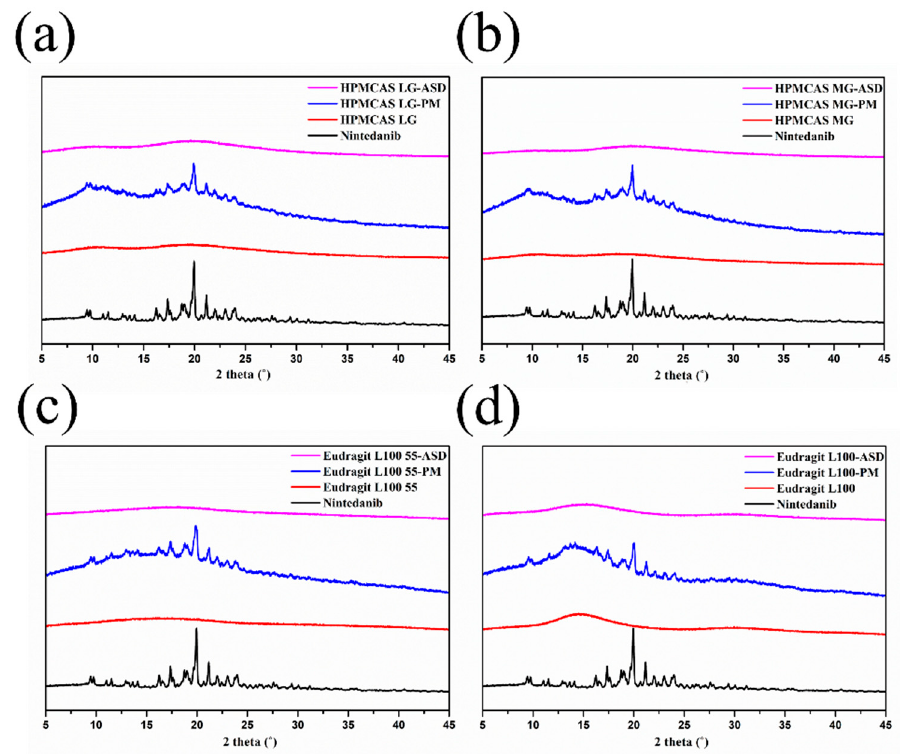
Figure 7. PXRD diffractograms of nintedanib and samples with ( a ) HPMCAS LG, ( b ) HPMCAS MG, ( c ) Eudragit L100 55, ( d ) Eudragit L100.